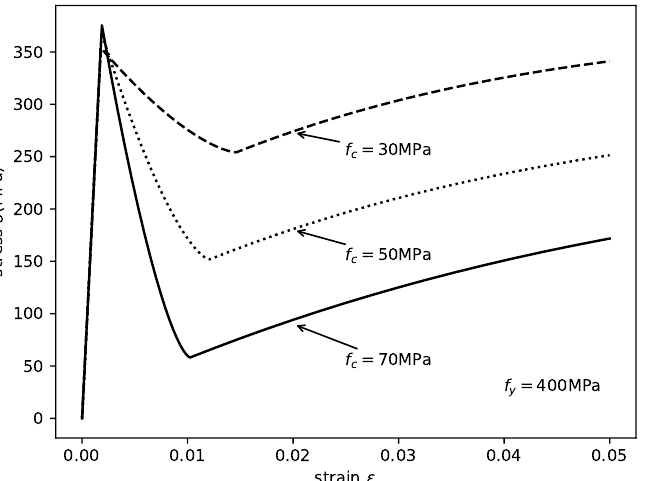
Figure 8. Axial stress–strain relationships of the steel tube in the CCFST columns with different concrete